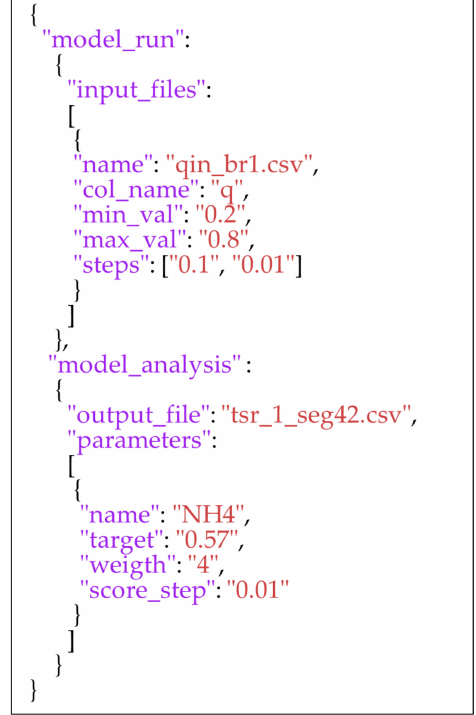
Figure A3. Case study input file.